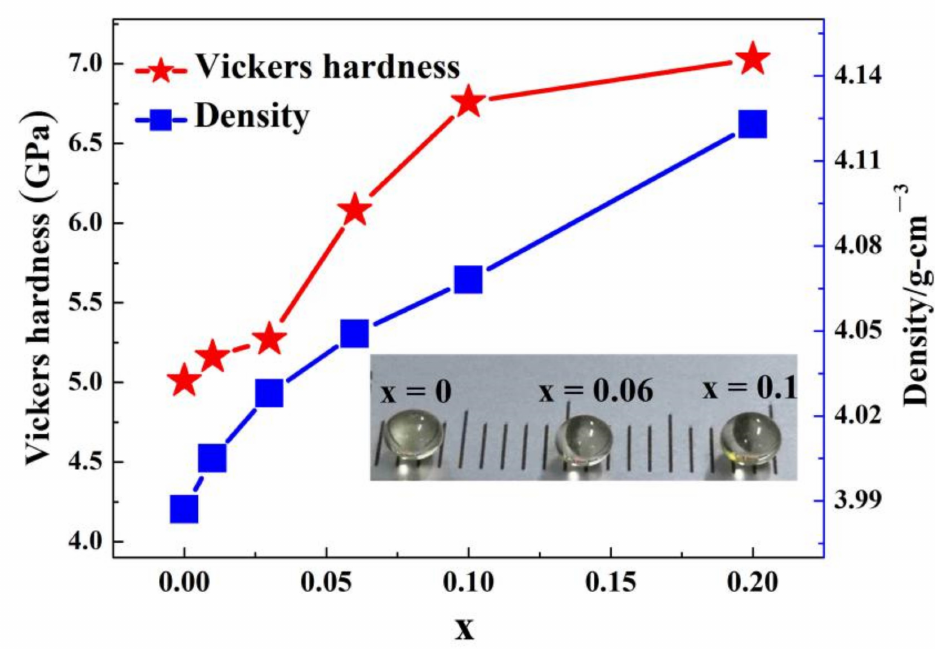
Figure 3. Vicker’s hardness and density of Al 2 O 3 -(3-x)SrO: xSm 3+ (x = 0, 0.01, 0.03, 0.06, 0.1, 0.2) glasses. The inset photo shows transparent samples of three randomly selected components with x = 0, 0.06,